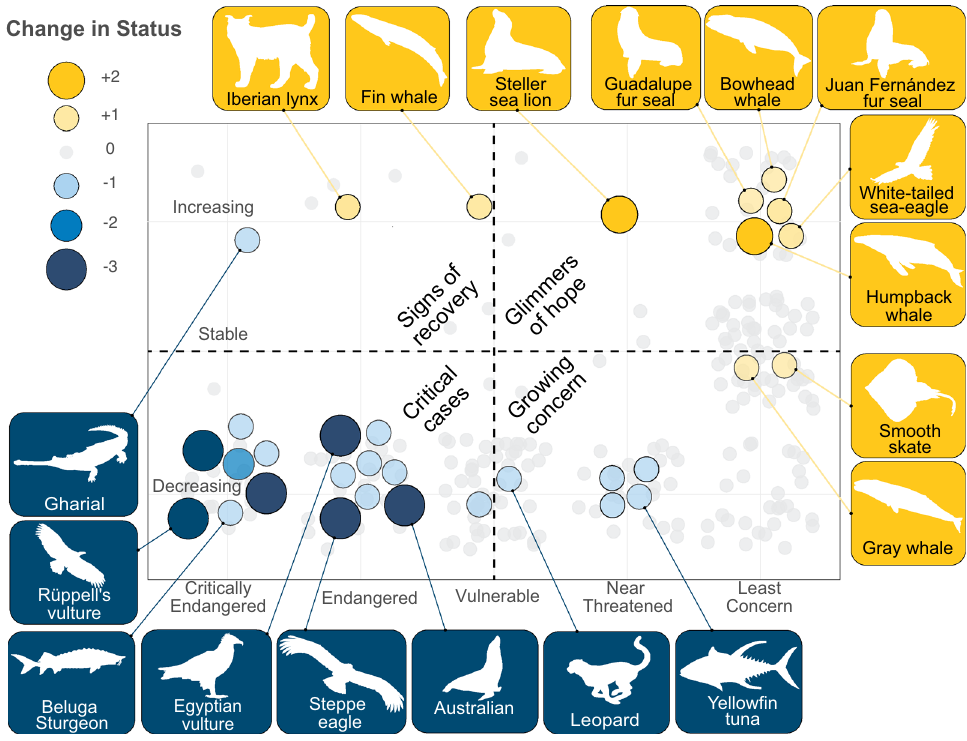
Figure 3. Glimmers of hope and critical cases. Distribution of large carnivore species across categories of current IUCN status (x-axis) and population trend (y-axis). Improvements in status are indicated by gold and declines by blue, with bubble size indicating the number of status category changes. The majority of species have not undergone any changes in status (shown in light gray). Note: No change in status may indicate lack of recent assessment, insufficient data, or, in the case of species designated Least Concern, effective conservation